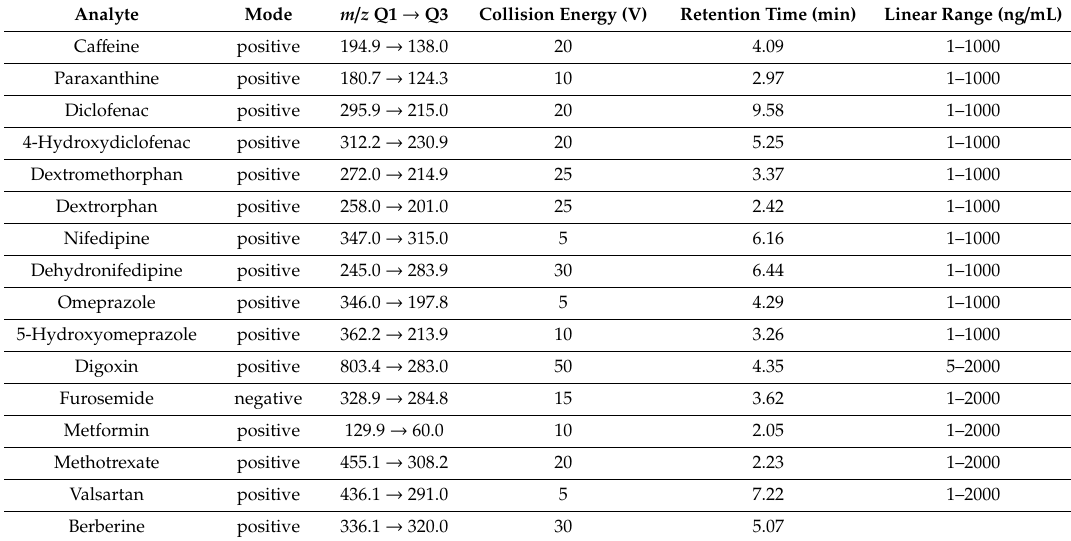
Table 2. MS / MS parameters for the detection of 15 probe substrates and